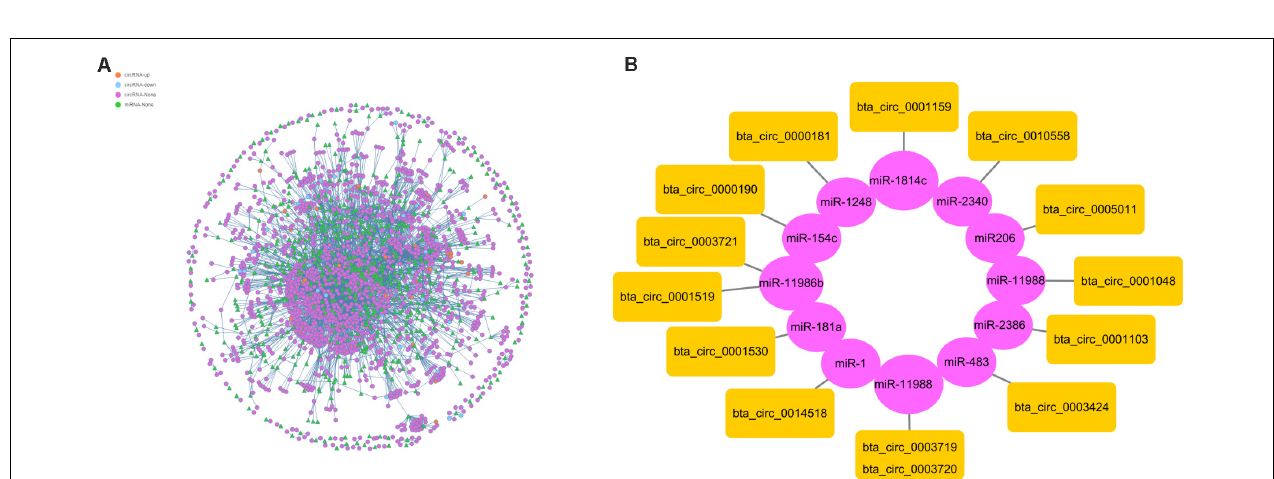
FIGURE 7 | Interaction between circRNAs and miRNAs. (A) The circle nodes represent circRNAs, and the triangle nodes represent miRNAs. The lines represent the relationship between circRNAs and miRNAs. (B) Prediction of the target relationships between miRNAs and